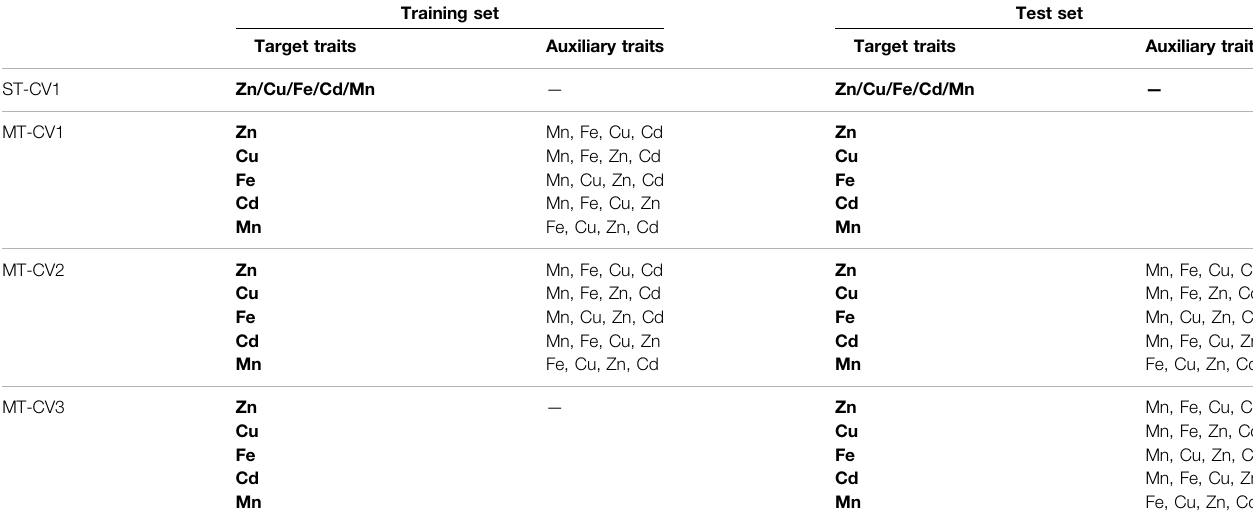
TABLE 1 | Investigated single trait (ST) and multi-trait (MT) cross-validation (CV) schemes. Training set Test set Target traits Auxiliary